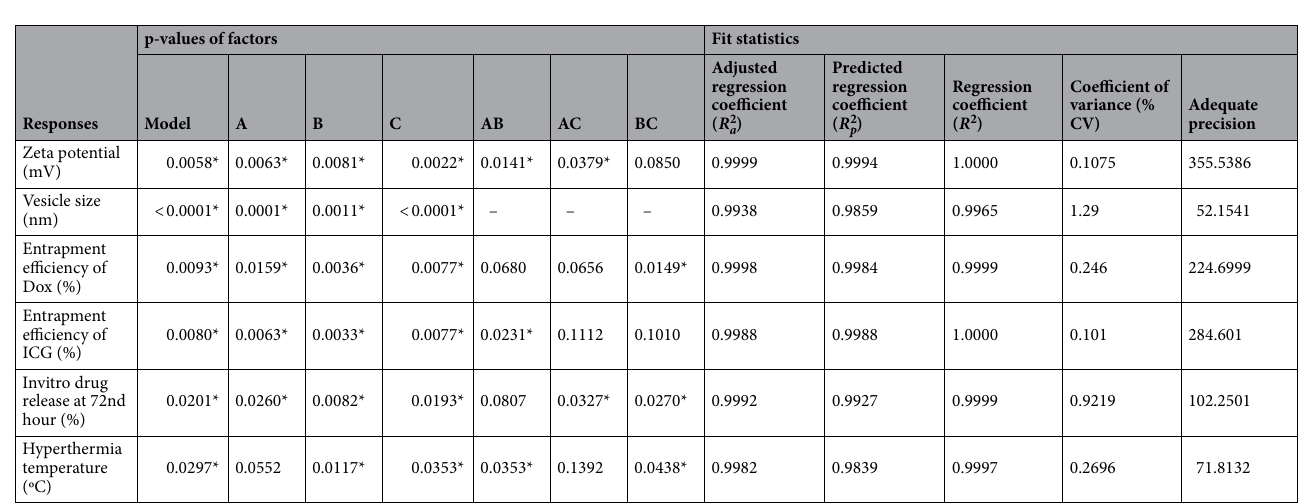
Table 4. Descriptive statistical analysis of models. *Significant p value (< 0.05), model term p value (<